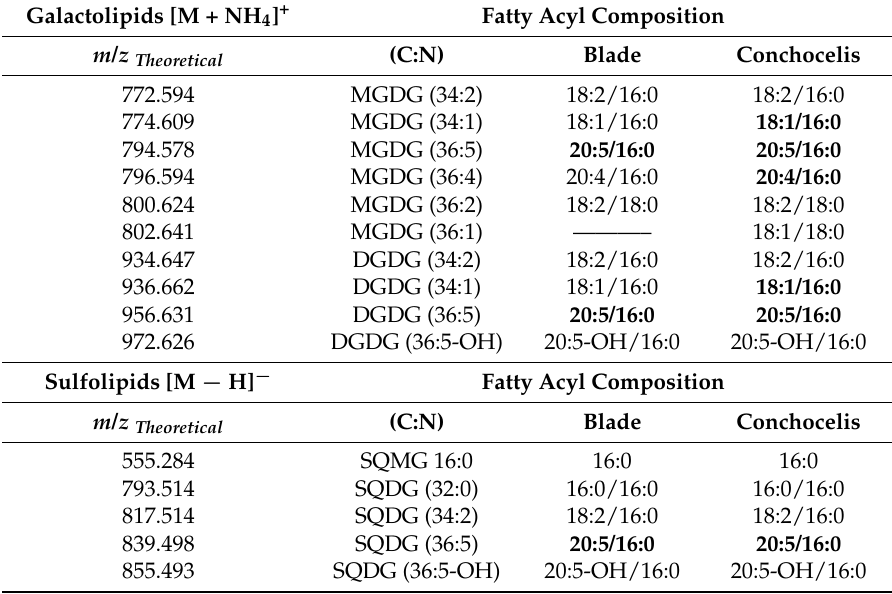
Table 2. Identification of glycolipids in the lipidome of blade and conchocelis stages of Porphyra dioica by HILIC–LC–MS, mass accuracy and MS/MS. Monogalactosyl diacylglycerol (MGDG) and digalactosyl diacylglycerol (DGDG) molecular species were identified as [M + NH 4 ] + ions, and sulfoquinovosyl diacylglycerol (SQDG) and sulfoquinovosyl monoacylglycerol (SQMG) molecular species were identified as [M − H] − ions. Galactolipids [M + NH 4 ]